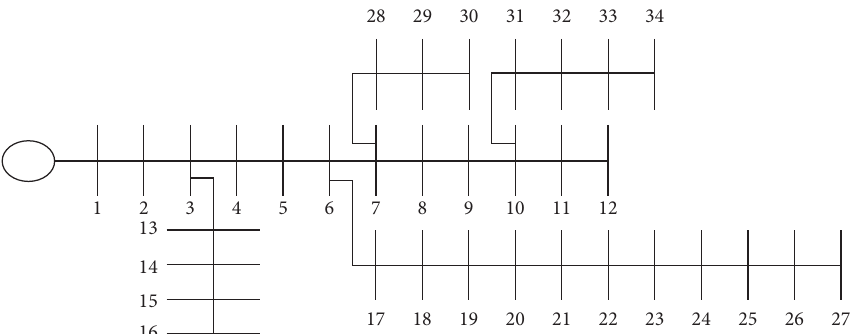
Figure 1: One line diagram of the IEEE 34 bus system.